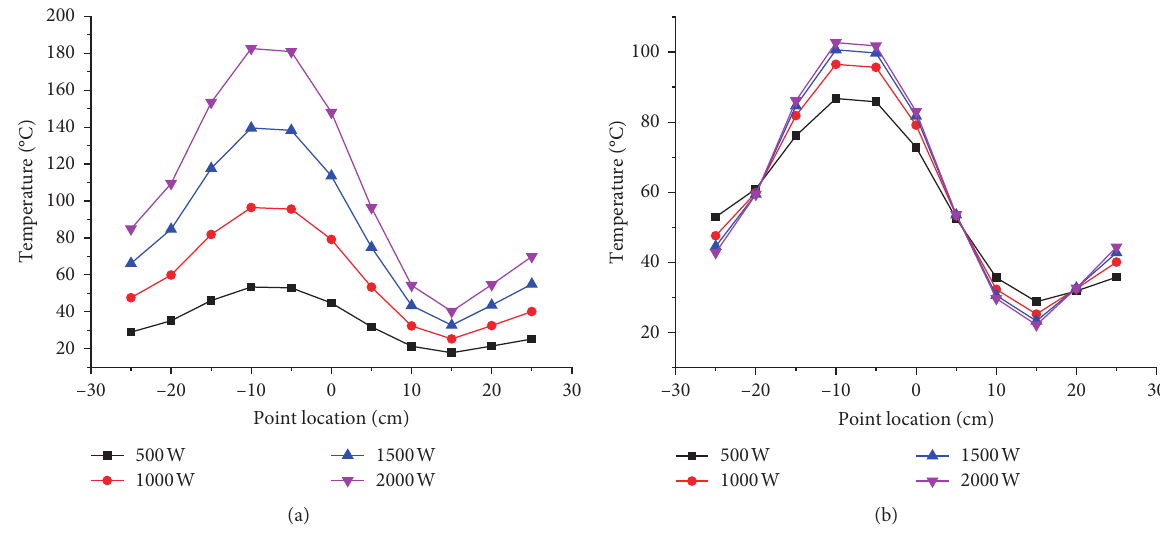
Figure 11: Distribution of temperature at different positions in the coal sample. Different microwave powers with (a) the same irradiation time and (b) the same input